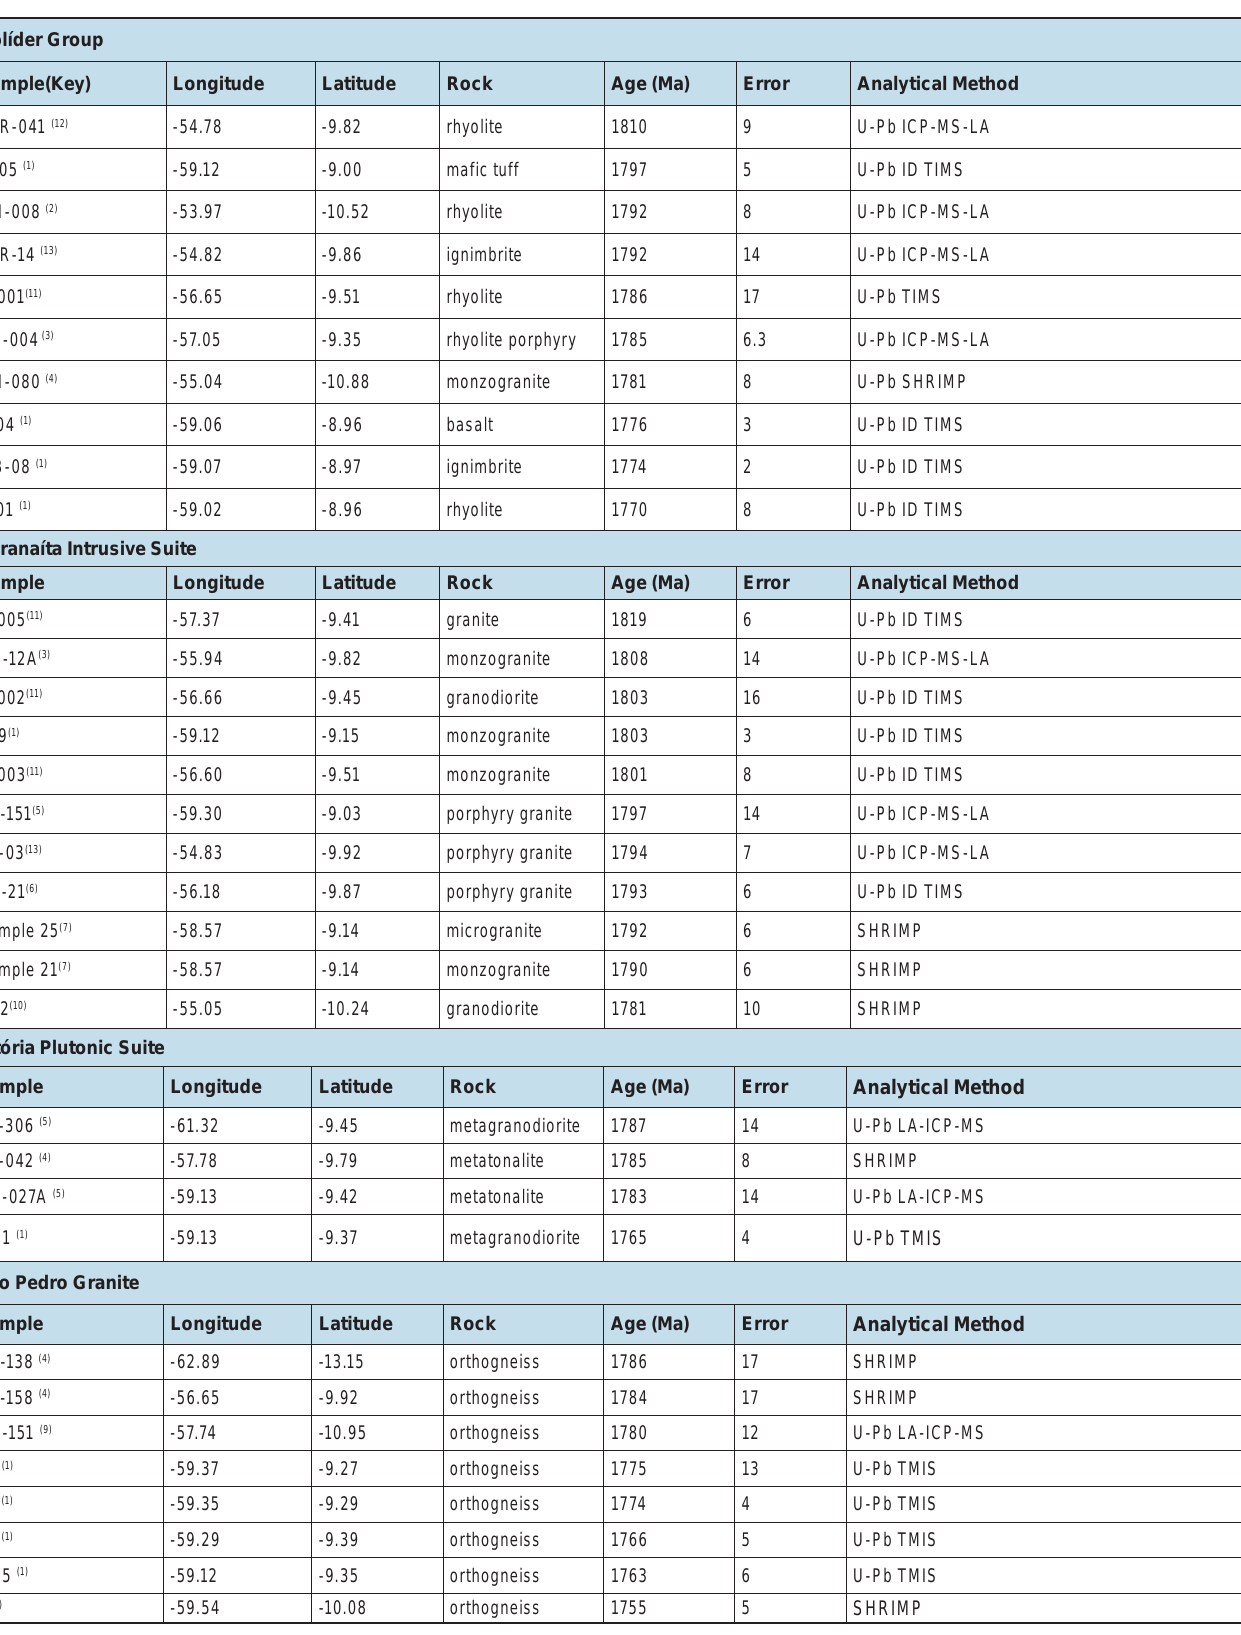
TABLE 1 - U-Pb (zircon) isotopic dating results and crystallization ages for the Volcanic Domain and Juruena Complex (Vitória Plutonic Suite and São Pedro Granite) (dataset from